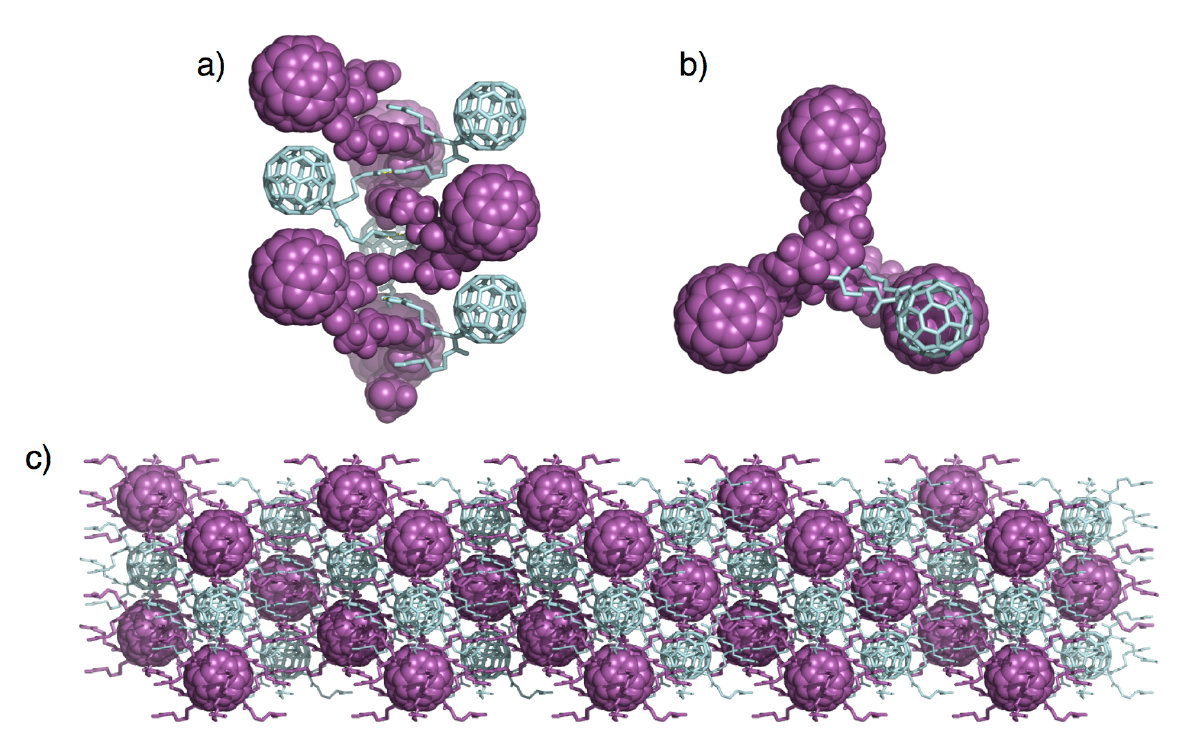
Figure 5: Interpenetration of two distinct hydrogen bonding networks for HFF-3 : a) side view indicating the spiral staircase-like cross-linking of indi- vidual molecules of C4 , b) top view and c) side view highlighting the interpenetration of two networks colored in purple and cyan.